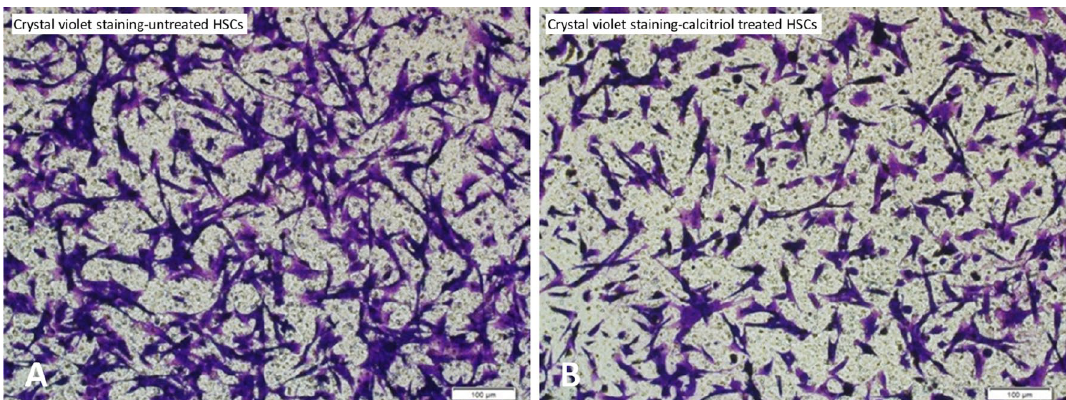
Figure 4. The Transwell assay showed that the migrated cell count of the untreated group ( A ) was higher than that of the 200 nM calcitriol treatment group ( B ) ( P <